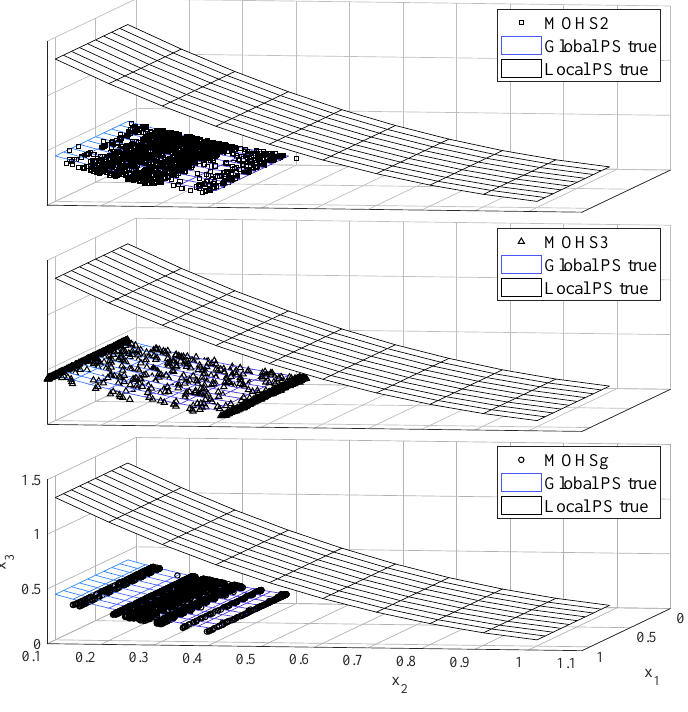
Figure 11. Pareto sets for problem P5.